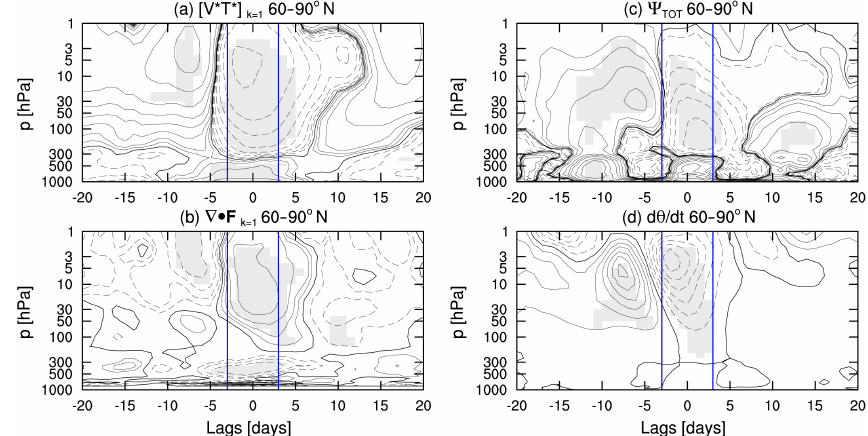
Figure 1. Evolution of DWC events as a function of time from days − 20 to + 20 and pressure from MERRA2: (a) wave-1 meridional heat flux anomaly (black contours), (b) wave-1 EP flux divergence anomaly, (c) residual mass–stream function anomaly, and (d) potential temperature tendency averaged from 60 to 90 ◦ N. The contour intervals are ± [1, 2, 4 ,8, 16, 32, ...]Km − 1 for (a) , ± [0.5, 1, 2, 4 , 8, 16, ...]ms − 1 day − 1 for (b) , ± 1 × 10 9 [0.5, 1, 2, 4, 8, 16, 32, 64, ...]kgs − 1 for (c) , and ± 0.5Kday − 1 for (d) . The gray shading indicates statistical significance at the 95% level using a 1000-trial Monte Carlo test. The periods of the maximum DWC event (days − 3 to + 3) are bounded by two vertical blue